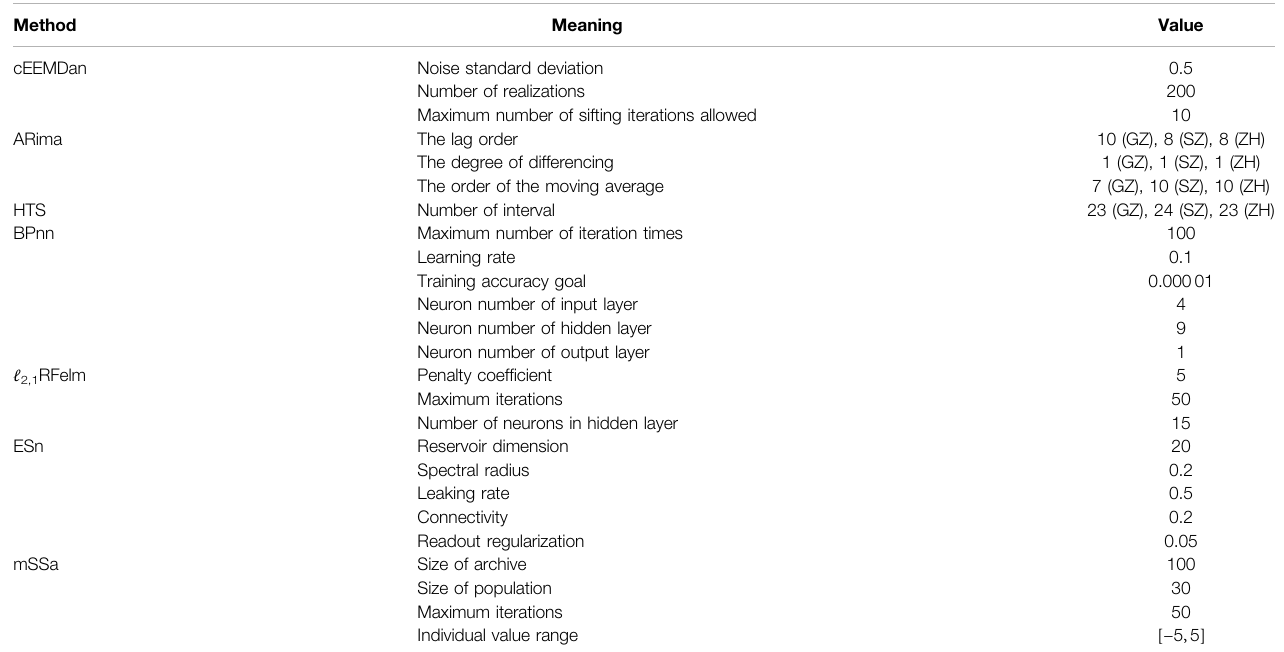
TABLE 5 | Experimental parameter settings of different individual models. Method